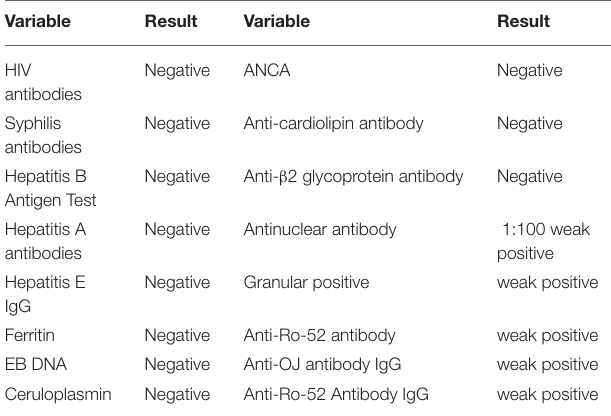
TABLE 1 | Relevant laboratory indicators for the diagnosis of disseminated tuberculosis.